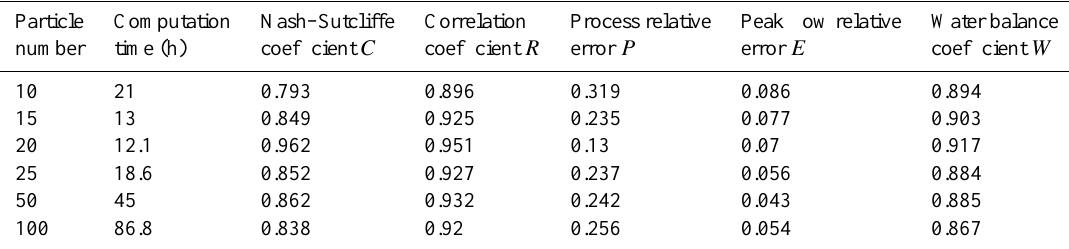
Table 5. Performances of PSO algorithm in Tiantoushui